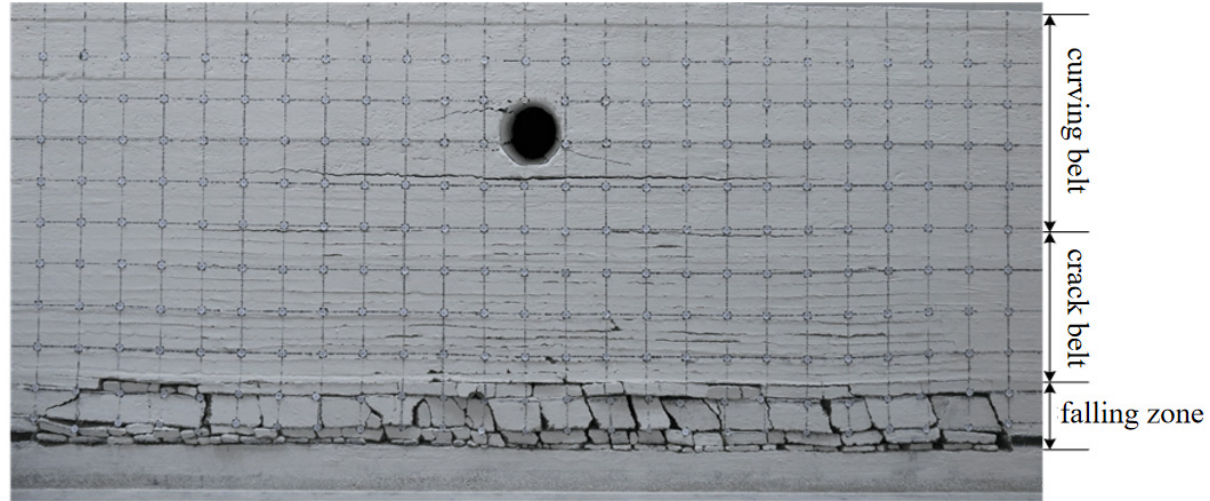
Figure 13. Division of three fracture zones in mining moving rock.